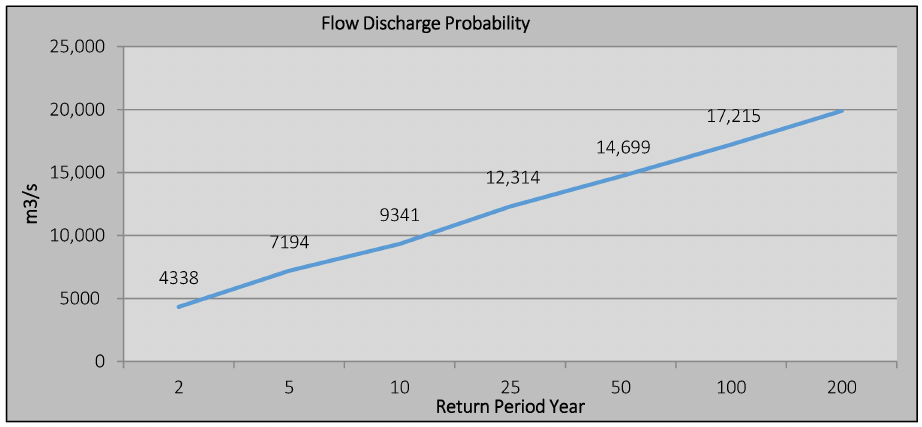
Figure 3. Flow discharge probability